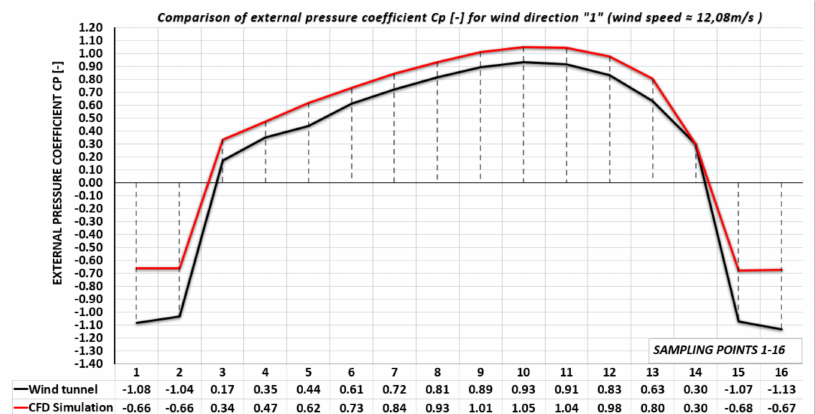
Figure 13. Comparison chart of external pressure coefficient for wind flow direction 1.